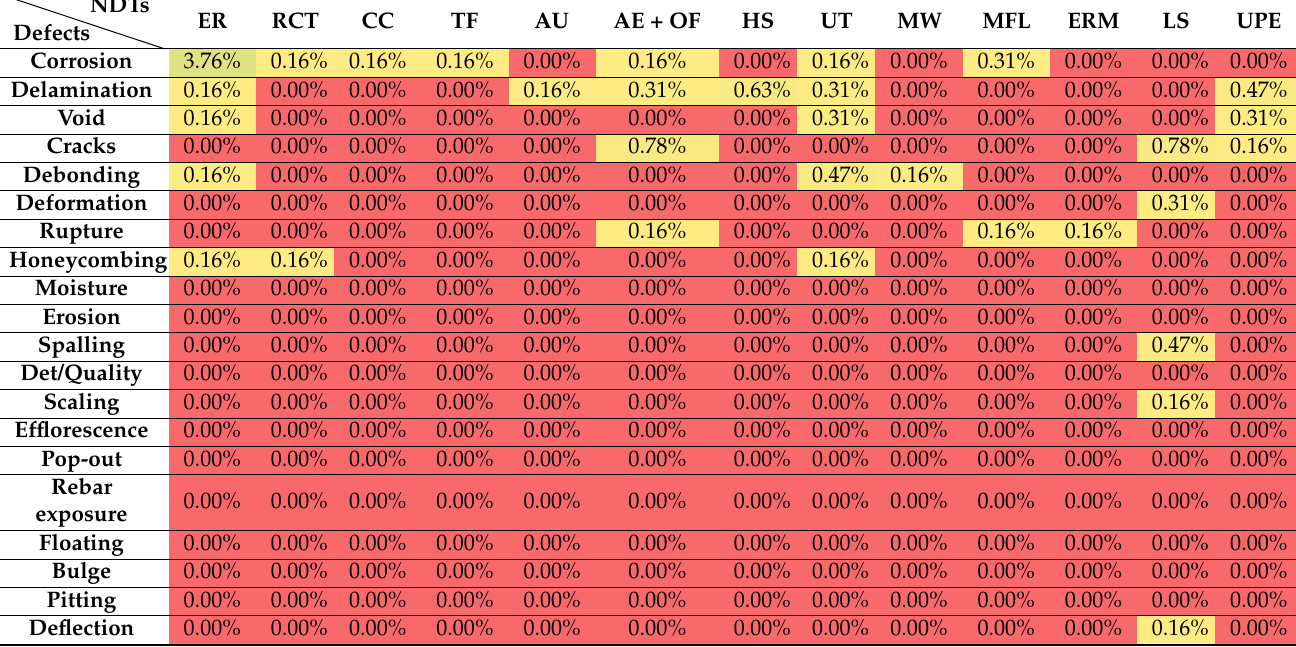
Table 11. Literature review matrix of concrete bridge defects and other used NDTs.